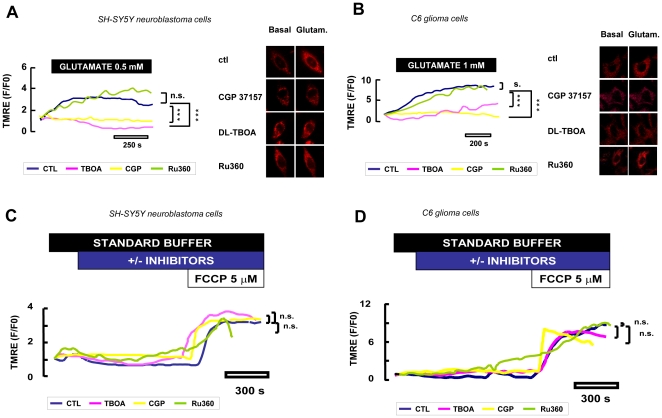
Real-time membrane potential analysis in intact cells.Experiments performed in SH-SY5Y (A,C) and C6 (B,D) cells using quenching concentration of the inner mitochondrial membrane potential indicator TMRE (150 nM). Glutamate perfusion induced mitochondrial depolarization (blue line). DL-TBOA (100 µM) and CGP-37157 (3 µM) both perfused from 20 min before through the end of recordings, prevented glutamate-stimulated mitochondrial depolarization (pink and yellow lines, respectively), while Ru360 (10 µM) was ineffective (green line). The resting condition inner mitochondrial membrane potential of SH-SY5Y neuroblastoma (A) or C6 glioma (B) cells was not affected by DL-TBOA (pink line), CGP-37157 (yellow line) or Ru360 (green line). The respiratory chain poison p-trifluoromethyl phenyl hydrazone (FCCP, 5 µM) was added at the end as an internal control in each experiment. For each group, more than 45 cells recorded in four different sessions were analyzed and the maximal depolarization induced after glutamate stimulation was used for the statistical analysis. *** p<0.001 vs control.